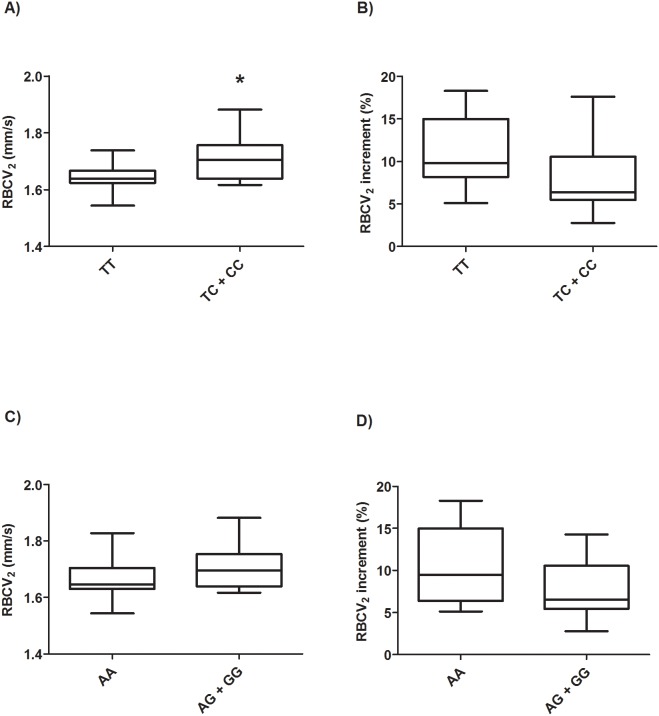
RBCV2 and RBCV2 increment in HD women according to ESR1 PvuII and Xbal genotypes.Data are presented as Whiskers plot. Comparison between groups was made by Mann Whitney test. RBCV2: Red blood cells velocity (mm/s) after estrogen administration. RBCV2 increment: Red blood cells velocity increment (%) after 1 min ischemia and subsequent reactive hyperemia response upon occlusion release after estrogen administration. A and C, RBCV2 and PvuII and Xbal genotypes, respectively. B and D, RBCV2 increment and PvuII and Xbal genotypes, respectively.